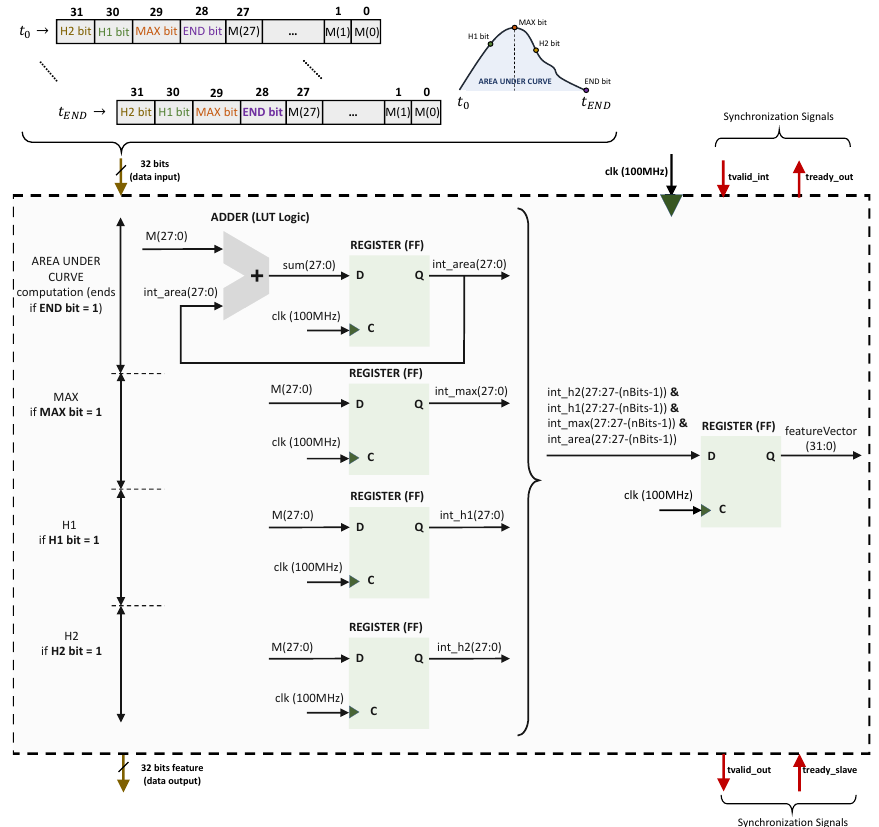
Figure 8. Proposed implementation of the VHDL Features Computing Module in Figure